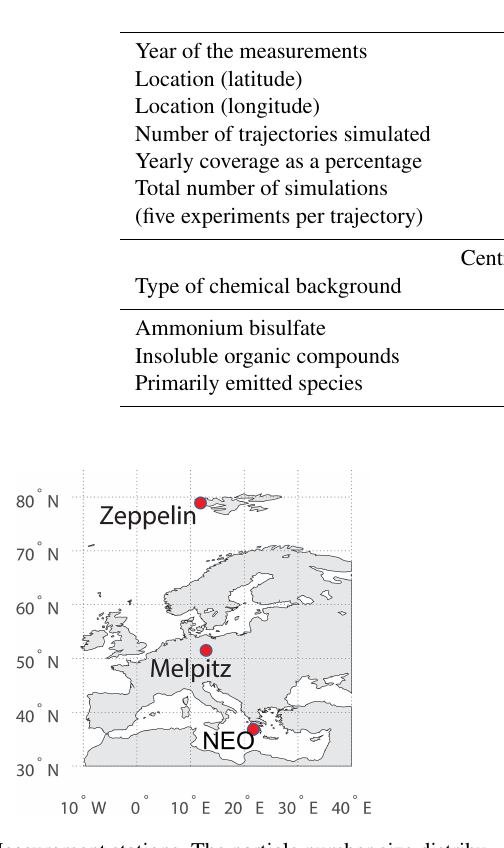
Figure 2. Measurement stations. The particle number size distribu- tion (PNSD) measured at the stations are used to initiate the trajec- tory